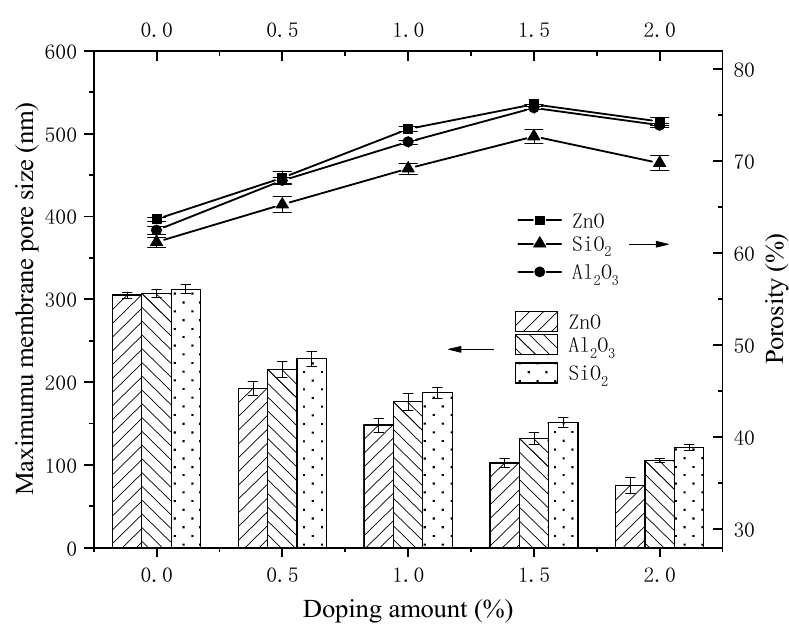
Figure 3. The effect of maximum pore size and porosity of prepared membranes under different doping amounts of nano-SiO 2 , nano-Al 2 O 3 and nano-ZnO.